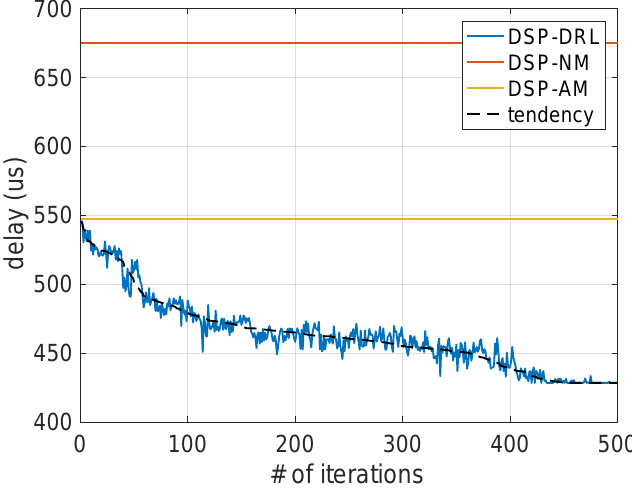
Figure 7. The convergence on total delay of 40